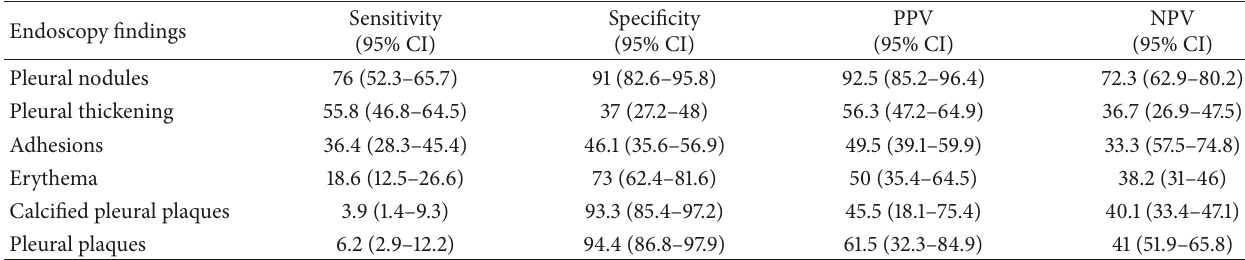
Table 4: Performance characteristics of endoscopic findings related to malignancy, in 218 patients undergoing medical thoracoscopy for diagnostic purposes.